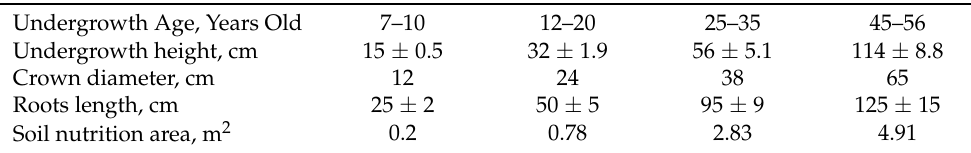
Table 3. Model specimen average parameters for Pinus sibirica undergrowth by age group (the N value is